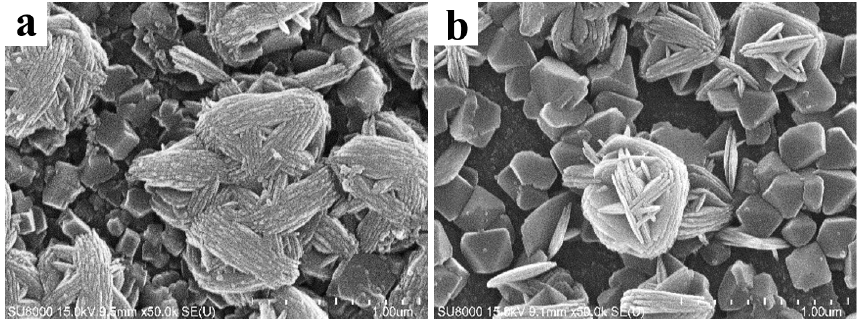
Figure 5. SEM morphologies of anatase coatings grown at 170 °C for 6 h in solutions containing: ( a ) 18 mL alcohol, 140 µ L TBOT, 70 µ L HF, 140 µ L NH 4 F (0.1 M); ( b ) 18 mL alcohol, 140 µ L TBOT, 70 µ L HF, 140 µ L NH 4 F (0.2 M).